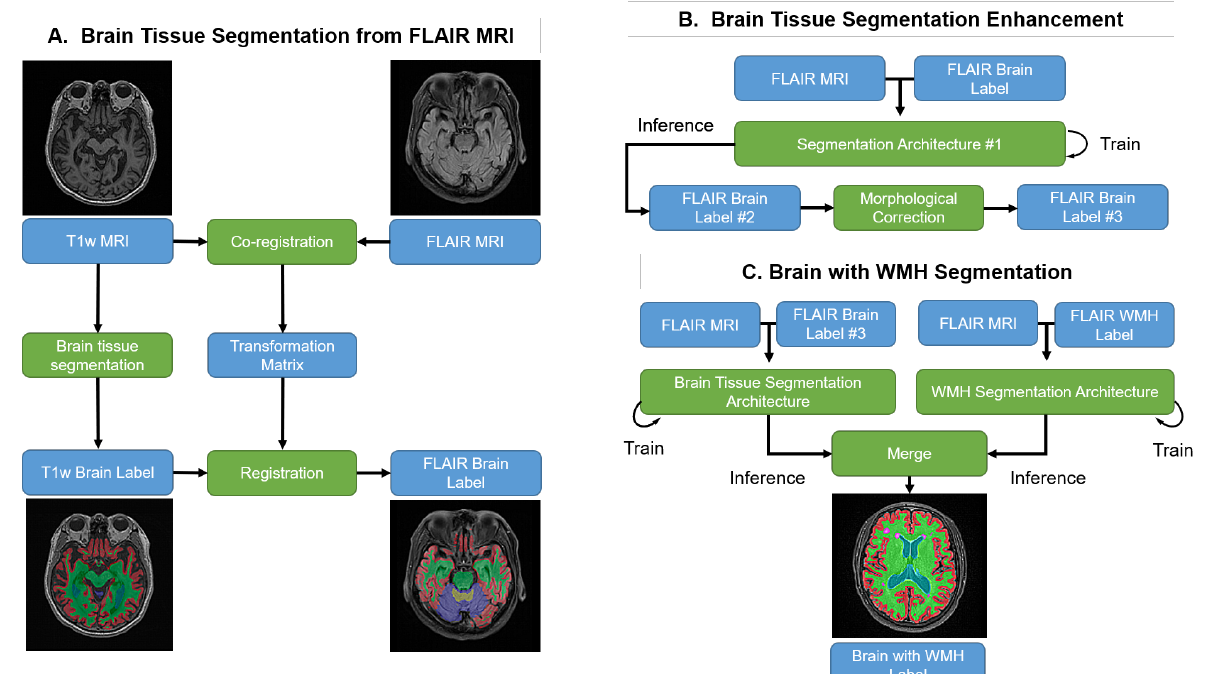
Figure 1. Pipeline of the proposed method. Blue boxes: input or output data; Green boxes: computational